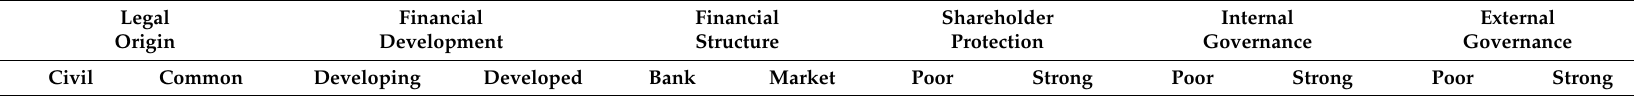
Table 6. The impact of institutions on target capital structure during the global financial